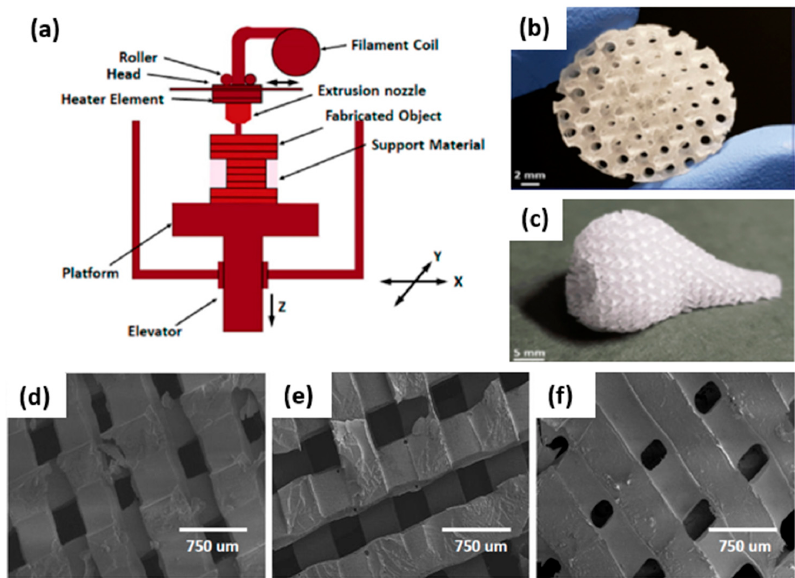
Solvent-free 3D sca ff olds obtained by the fused deposition modeling Figure 2. Solvent-free 3D scaffolds obtained by the fused deposition modeling technique: ( a ) Thermoplastic materials are molten into a liquid state in a liquefier head. Then, compounds are deposited through a nozzle that obeys a computer-aided design (CAD) file and generate 3D parts in a layer-by-layer fashion [23]. ( b ) Polydimethylsiloxane (PDMS) scaffold fabricated with complex geometries and gradient porous structures, including uniform and graded distributions with different pore shapes. ( c ) Porous nose fabricated with a fused deposition modeling (FDM) printing approach and showing the potential to generate structures with complex architectures to achieve human organ shapes [26] . ( d – f ) SEM images of PLA templated poly-(esterurethane) (PUR) scaffolds fabricated by fused deposition modeling with tunable substrate modulus (5, 24 and 266 MPa) [27]. ( b , c ) reprinted